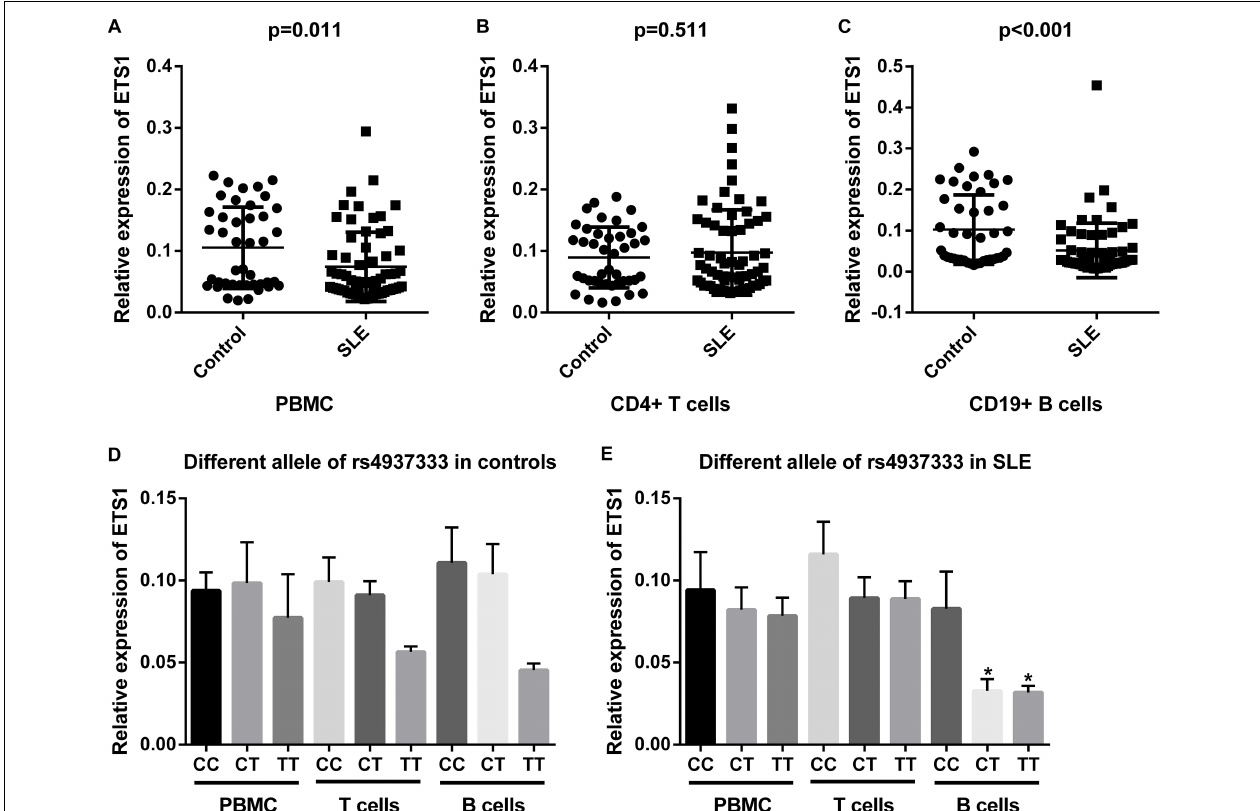
FIGURE 2 | mRNA expression of ETS1 in (A) PBMCs, (B) CD4+ T cells, and (C) B cells from SLE patients and controls. rs4937333 allele-specific expression of ETS1 in PBMCs, B cells, and CD4+ T cells in (D) controls and (E) SLE patients. ∗ P < 0.05 vs. the CC genotype in the same